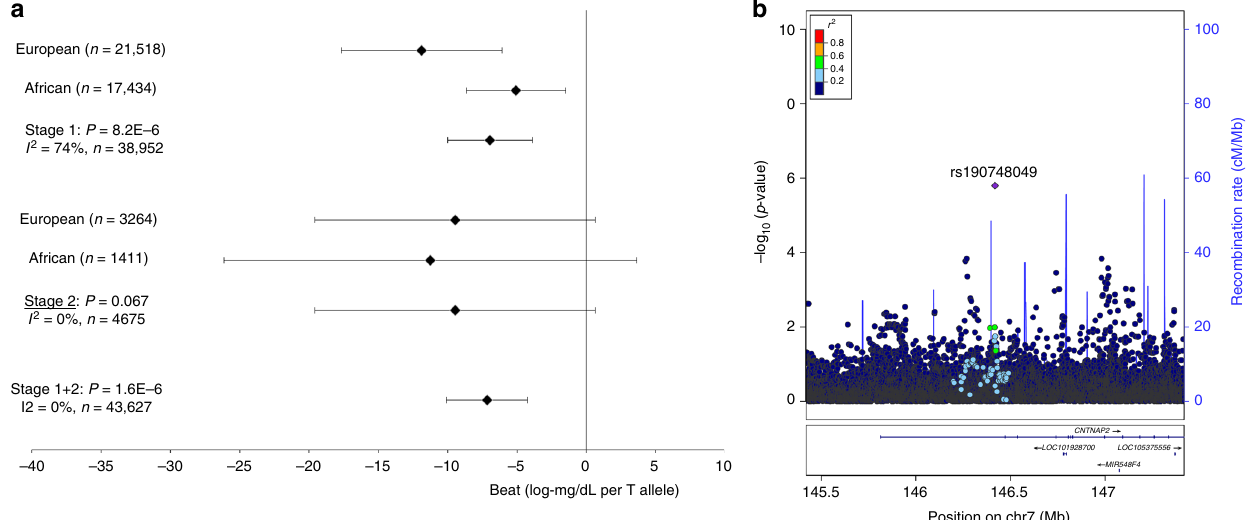
Fig. 5 Interaction of rs190748049 variant in CNTNAP2 with physical activity on LDL cholesterol levels. The rs190748049 variant was genome-wide signi fi cant in the joint test for SNP main effect and SNP × physical activity interaction and reached P = 2 × 10 − 6 for the SNP × physical activity interaction term alone. The beta and 95% con fi dence intervals in the forest plot ( a ) is shown for the SNP × physical activity interaction term, i.e., it indicates the decrease in LDL cholesterol levels in the active group as compared to the inactive group per each T allele of rs190748049. The − log 10 ( P value) in the association plot ( b ) is also for the SNP × physical activity interaction term. The P values are two-sided and were obtained using a meta-analysis of linear regression model results. The fi gure was generated using LocusZoom (http://locuszoom.org)